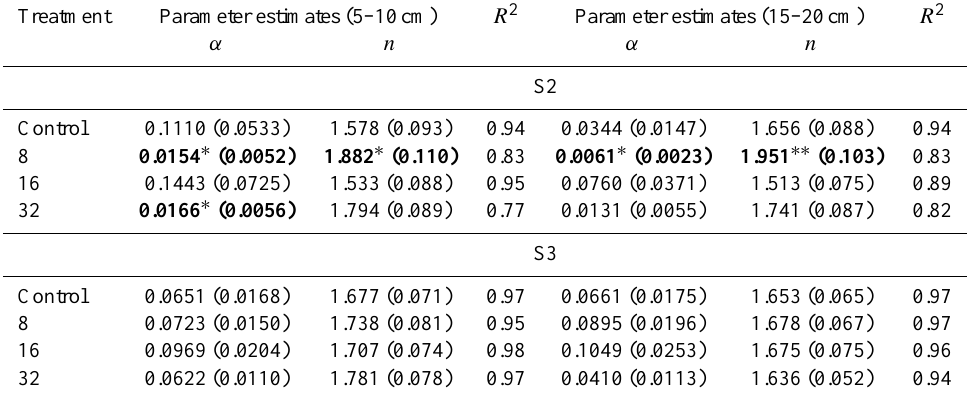
Standard error of estimates are within parentheses ( n = 4 ). Nominal significance level of t test for contrasts between control and treatments with biochar within season and soil layer: ∗∗ p ≤ 0.05 and ∗ 0.05< p ≤ 0.10; R 2 : the squared Pearson correlation coefficient between measured and predicted soil moisture means ( n = 24 ). Table 2. Response of key physical hydric variables to biochar rate (char) at 2 (S2) and 3 (S3) years after application in a sandy Dystric Plinthosol